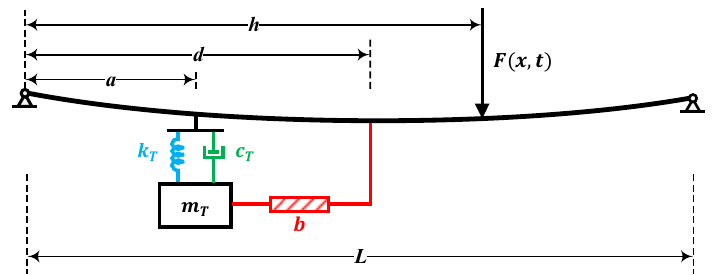
Figure 3. A schematic diagram of a transmission line with TMDI.